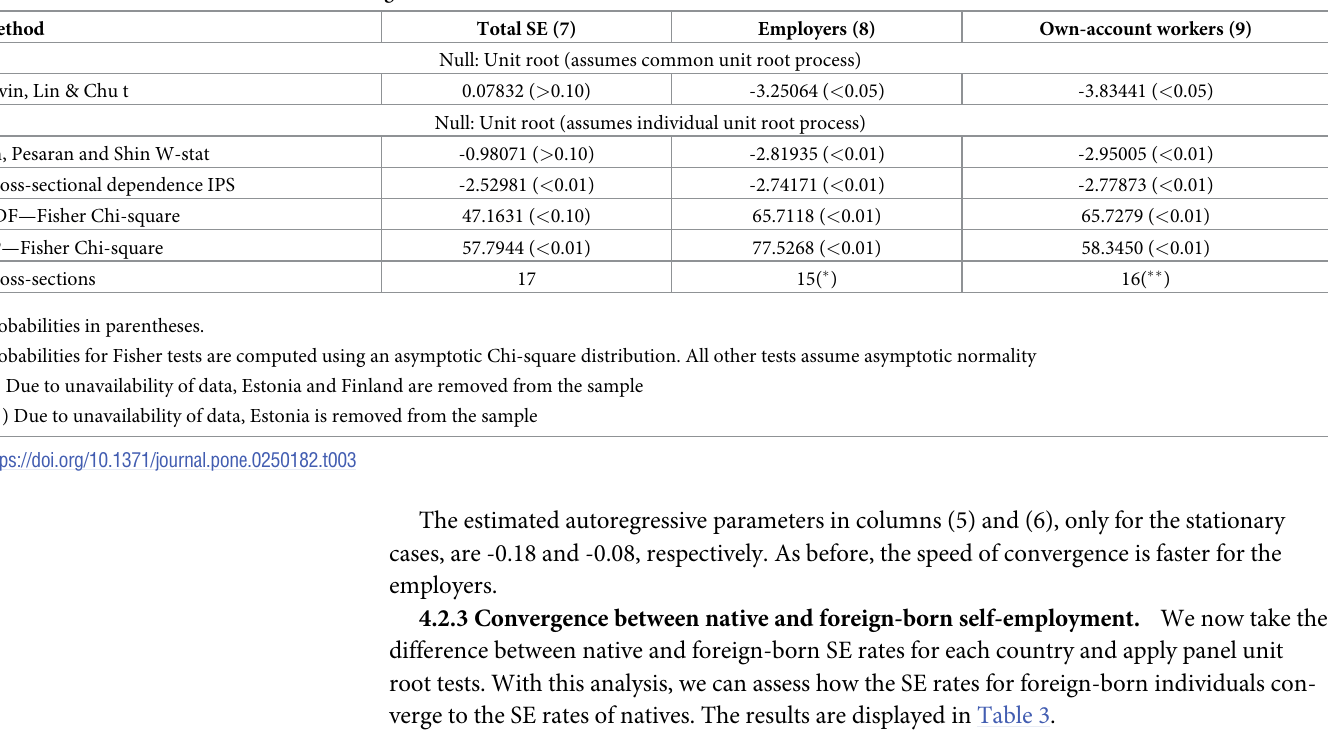
Table 3. Panel unit root test result native vs